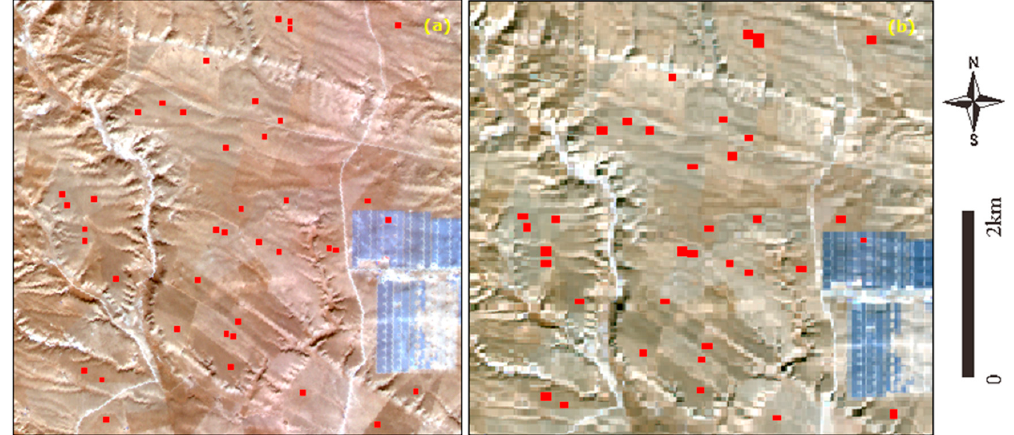
Figure 4. An example to show the selected calibration sites (red points) in concurrently collected Gaofen-1 WFV3 ( a ) and Landsat-8 OLI ( b ) images.